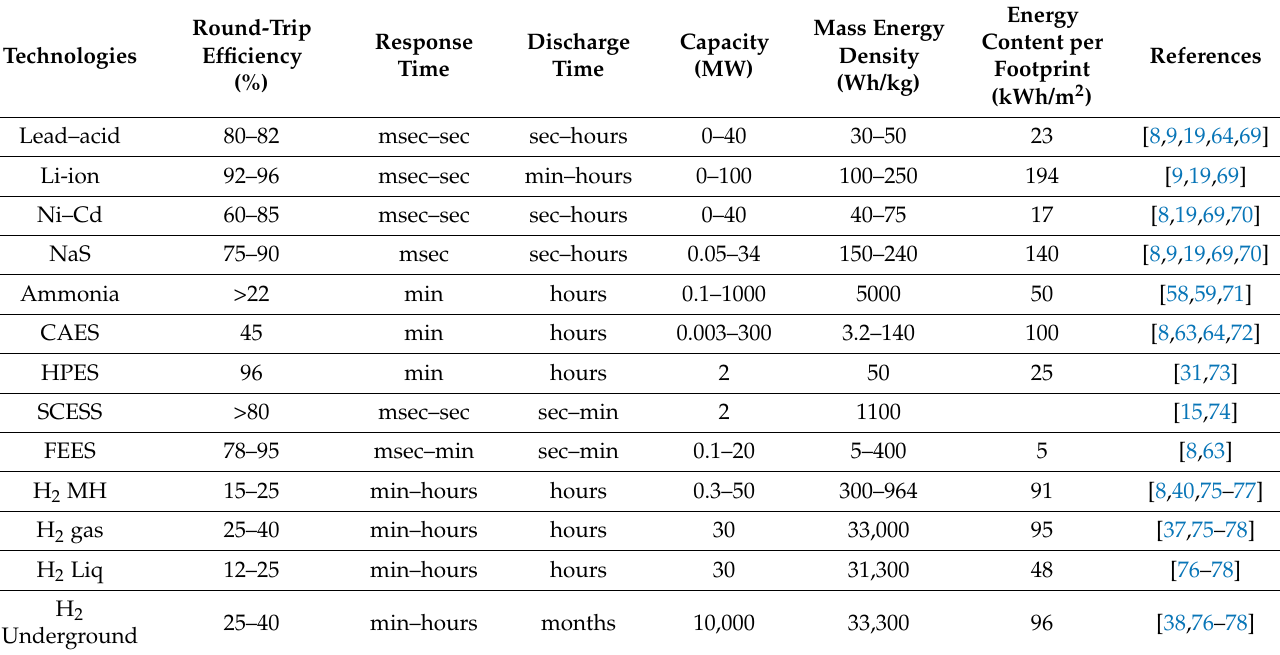
Table 3. Technical characteristics of energy storage technologies based on public